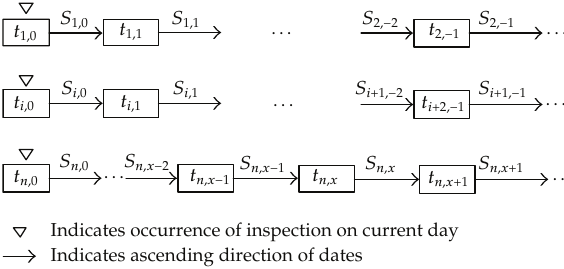
Figure 1: Evolutionary process of track irregularity over the unit section